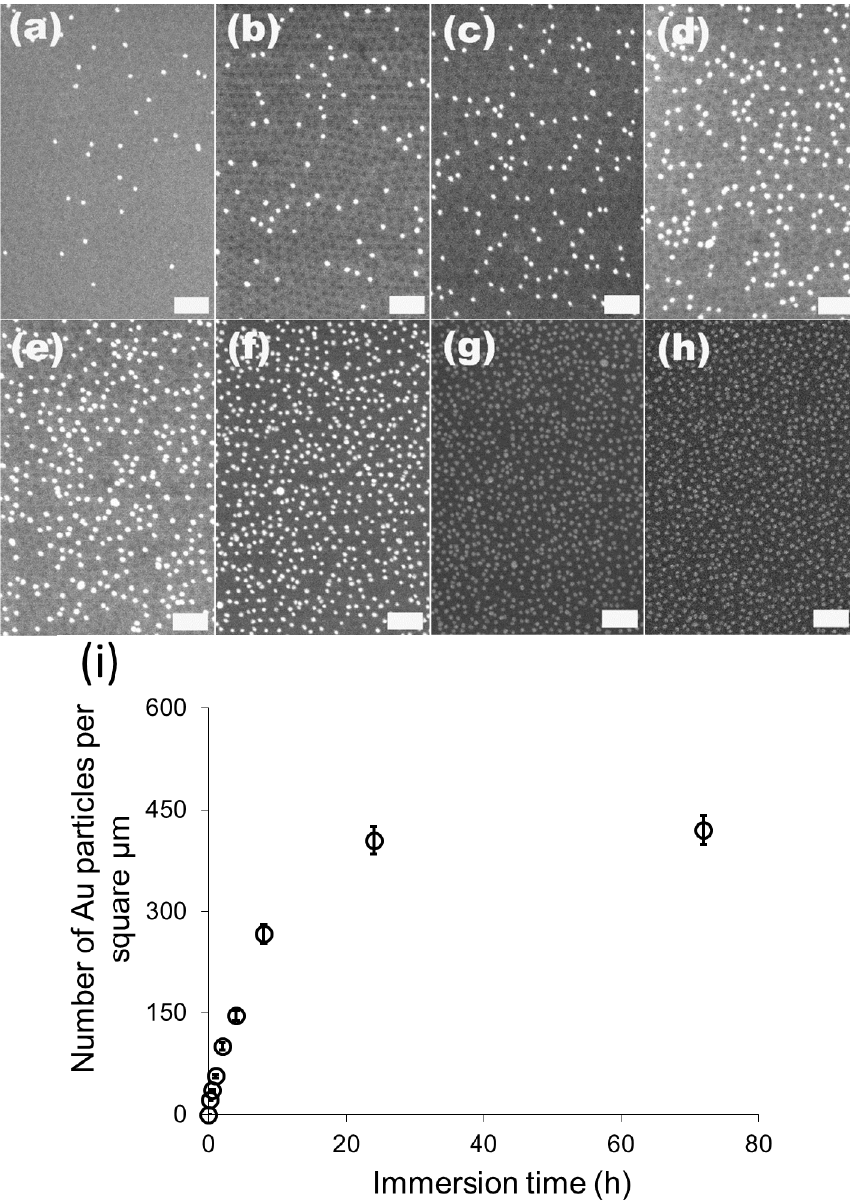
Figure 3. SEM images of 20 nm gold attached S2VP film after different immersion times ( a – g correspond to 10 min, 0.5 h, 1 h, 2 h, 4 h, 8 h, 24 h and 72 h, respectively, and the scale bar is 200 nm); and the dependence curve of number of the attached gold particles with immersion time ( h